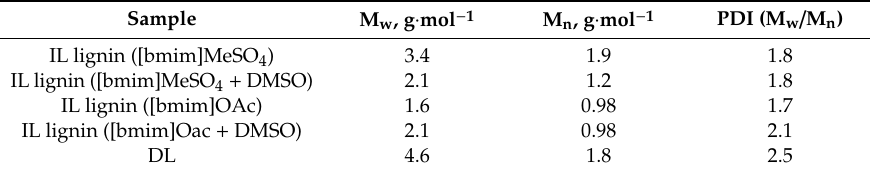
Table 1. Molecular weight properties of isolated IL lignins and dioxane lignin.